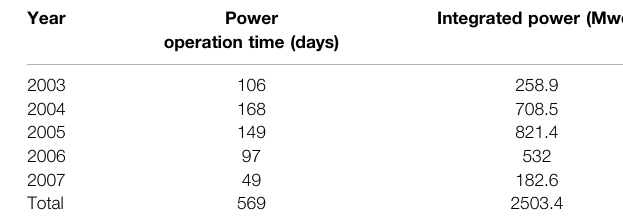
TABLE 1 | Summary of HTR-10 power history (Chen et al., 2014).